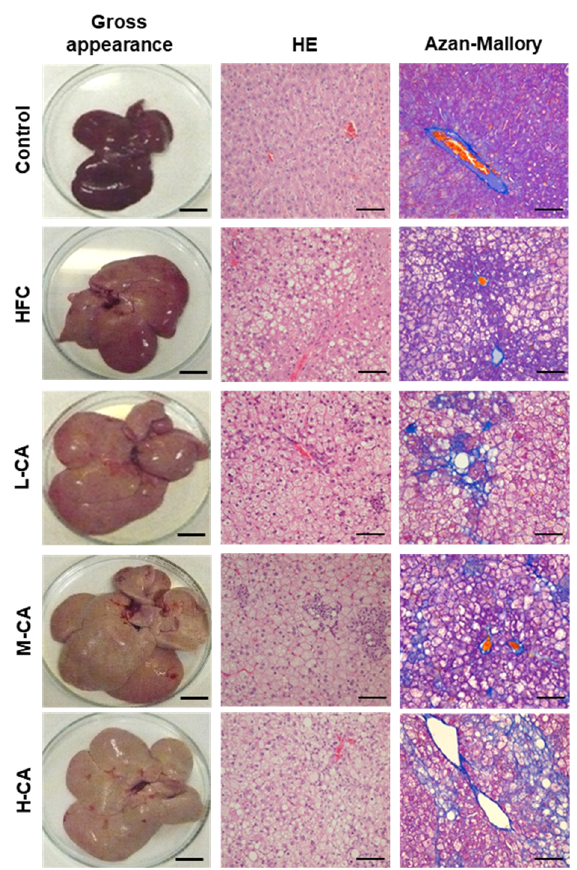
Figure 1. Representative liver morphology and histopathology in the control, HFC and L-CA, M-CA and H-CA groups. Gross appearance of liver surface; scale bars = 4 cm. Hematoxylin and eosin (HE)- and Azan-Mallory stained section; scale bars = 100 μ m. HFC, high-fat and high-cholesterol; L-CA, M-CA and H-CA, the HFC diet with 0.1%, 0.5% and 2.0% sodium cholate ( w / w ), respectively.